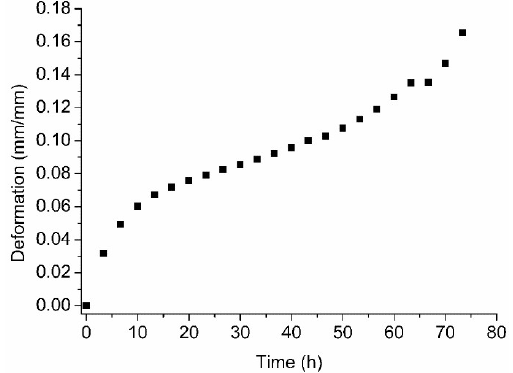
Figure 12. Creep curve of the Inconel 625 alloy at 650 °C and 600 MPa.